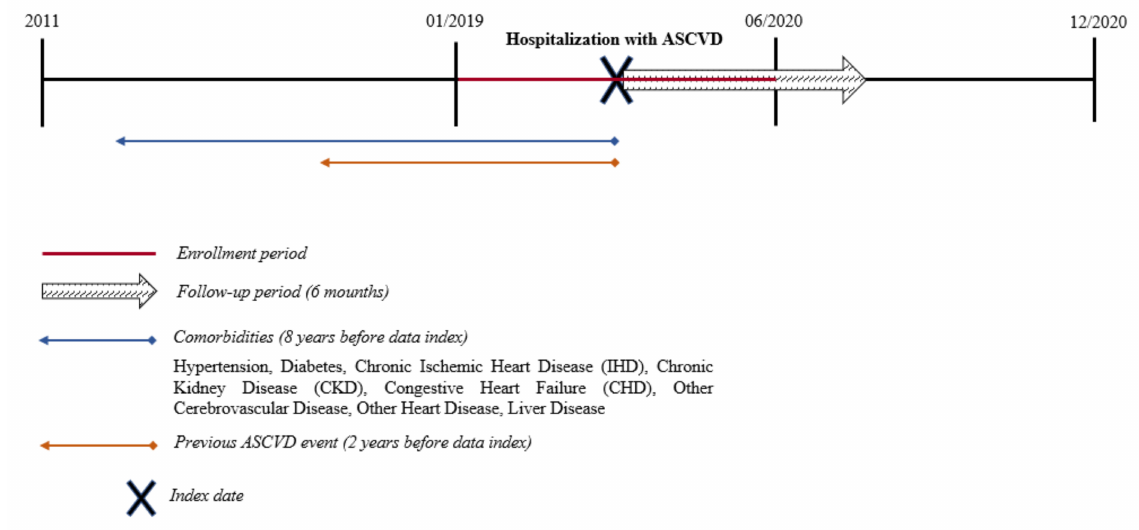
Figure 1. Study design. Atherosclerotic Cardiovascular Disease (ASCVD): Acute coronary syndrome (ACS), stable angina, unstable angina, stroke or transient ischemic attack (TIA), peripheral arterial disease (PAD), and revascularization procedures (percutaneous coronary intervention (PCI), coronary artery bypass graft (CABG) or other revascularization